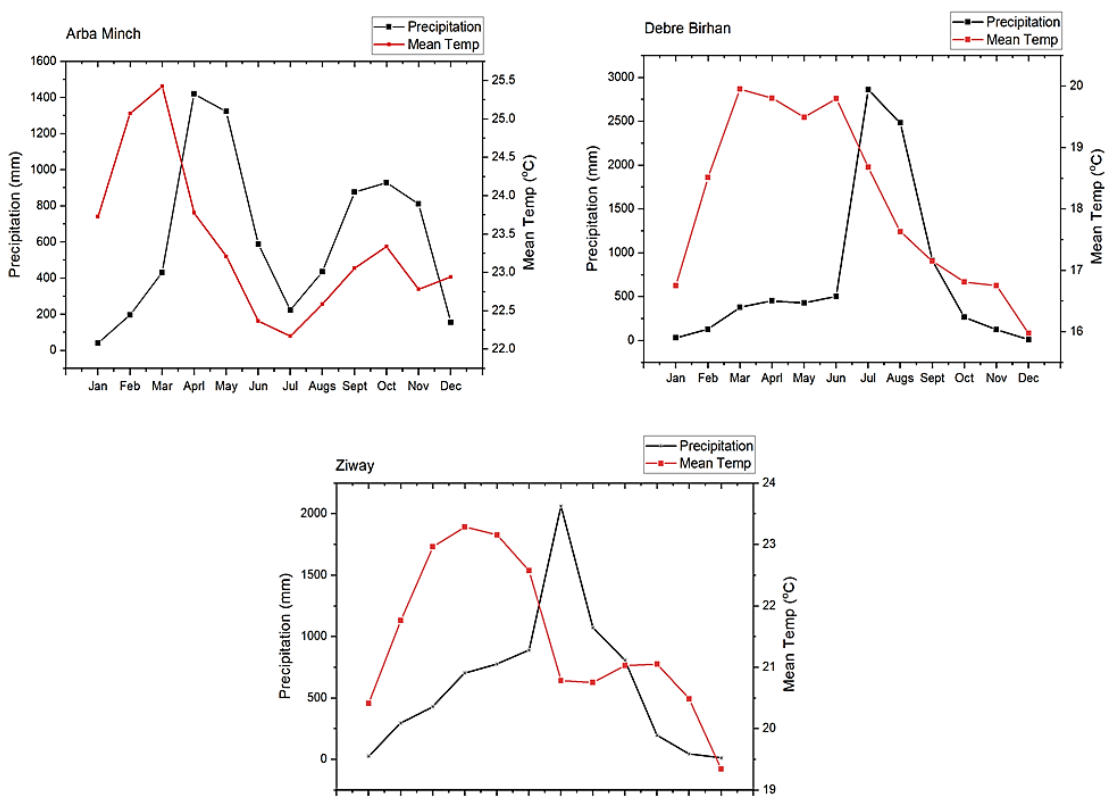
Figure 7. Total precipitation vs. mean temperature of the study areas (2012 – 2020).